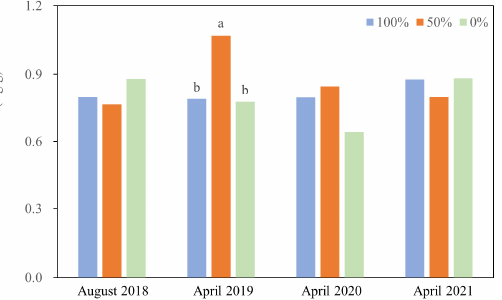
di ff erence. The treatments are 0%, 50%, and 100% crop residue removal